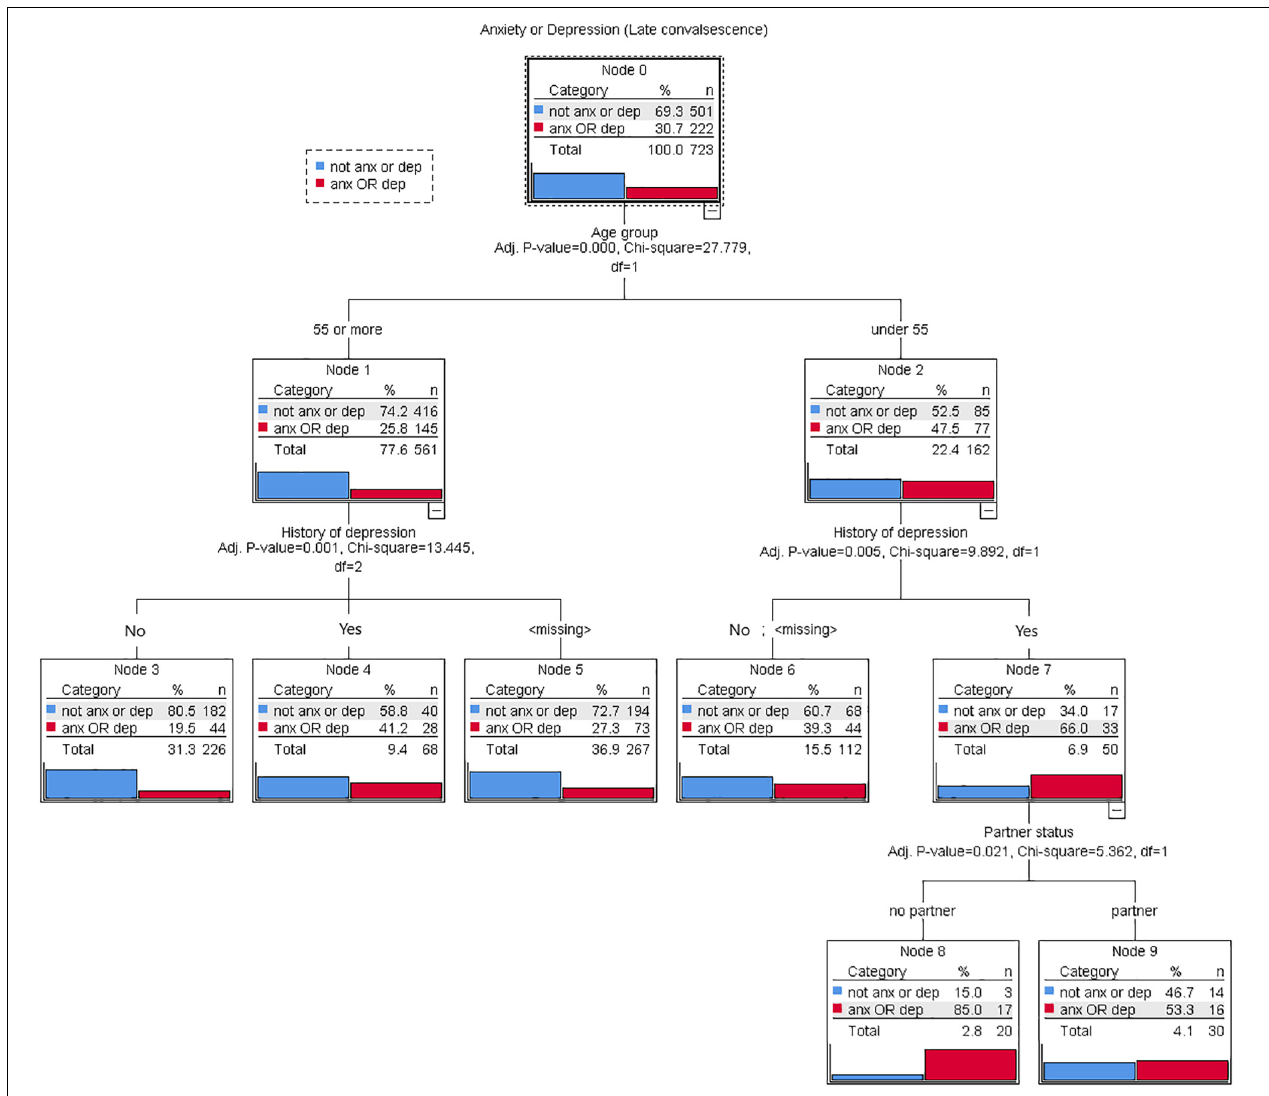
FIGURE 2 | Decision tree (using the CHAID algorithm) for predicting presence of anxiety or depression in late convalescence among 723 patients admitted to hospital for acute myocardial infarction (AMI), coronary artery bypass graft surgery (CABGS), acute coronary syndrome (ACS), percutaneous coronary syndrome (PCI), or angina. At each node the best predictor for anxiety or depression was selected from the six key potential predictors identified in bivariate analyses, and the optimal forecasting values were